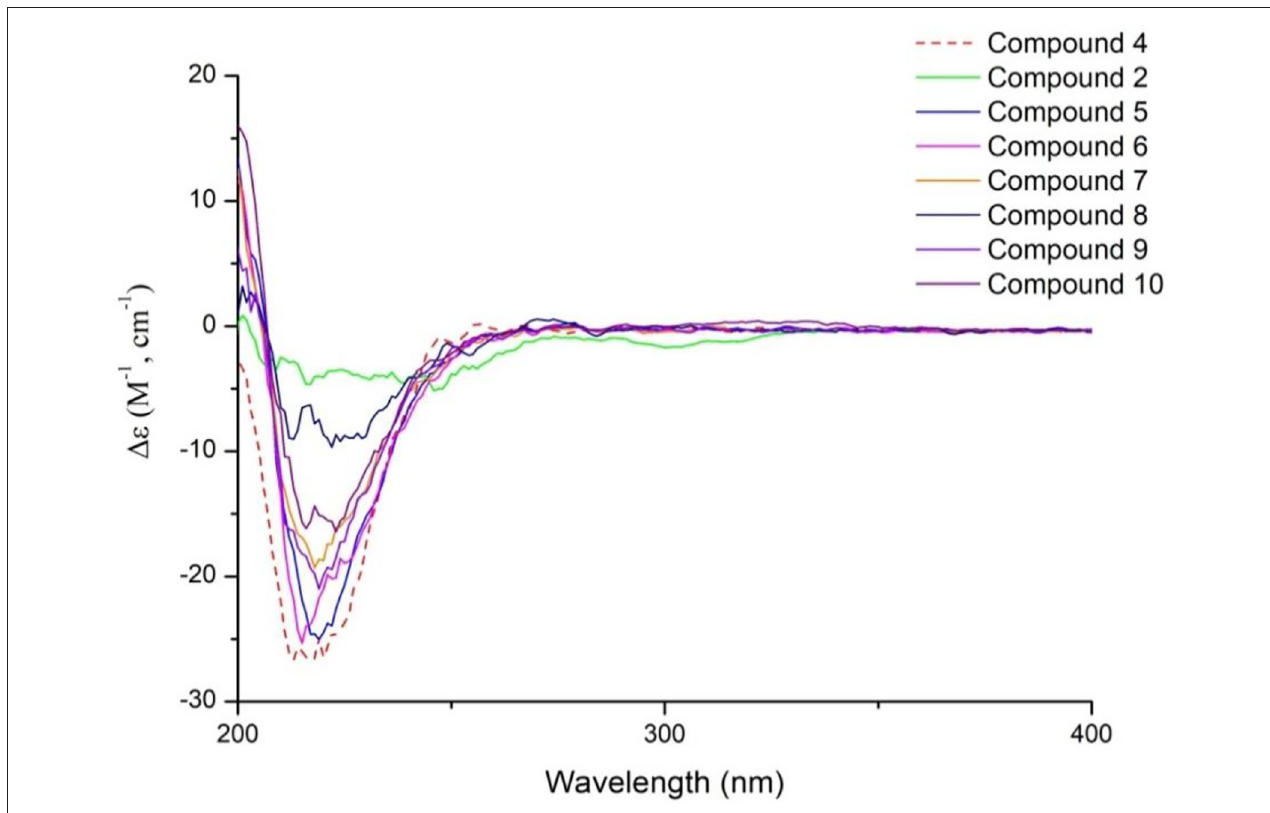
FIGURE 11 | Experimental ECD spectra of compounds 2 , 4 - 10 at TDDFT/B3LYP/6-31G(d) level.